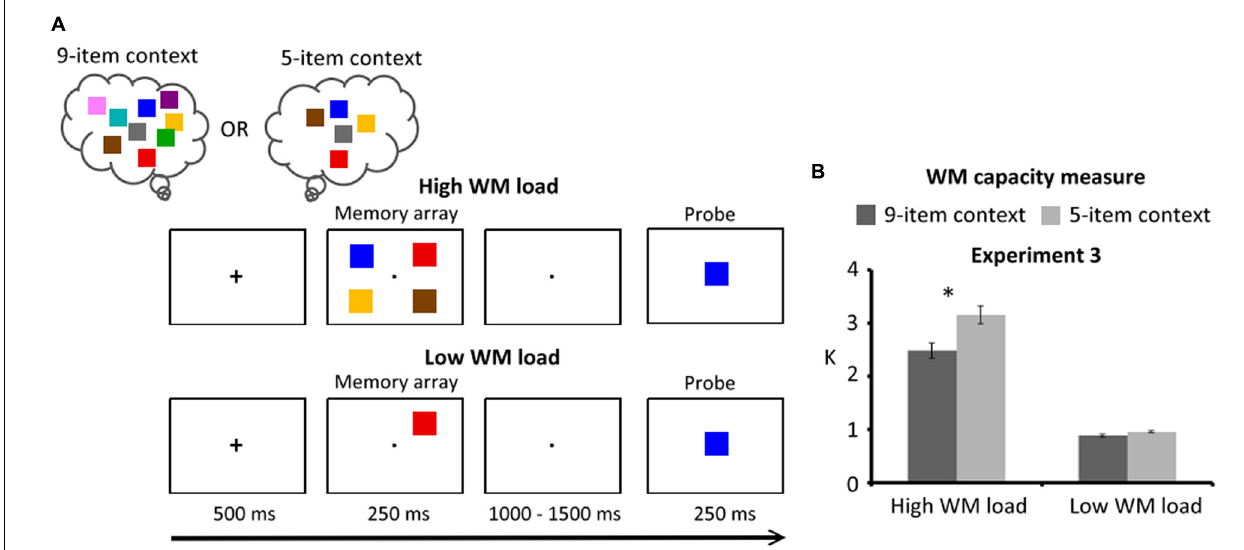
FIGURE 3 | (A) Schematic illustration of the delayed response task of Experiment 3. Participants were instructed to remember four colors (high WM load) or one color (low WM load) within the memory array for a delayed response. Selection history was defined as the number of items that have been activated in the task context (e.g., 5-item and 9-item). (B) WM capacity ( K estimates) for Experiment 3. Error bars represent standard errors of the means. WM, working